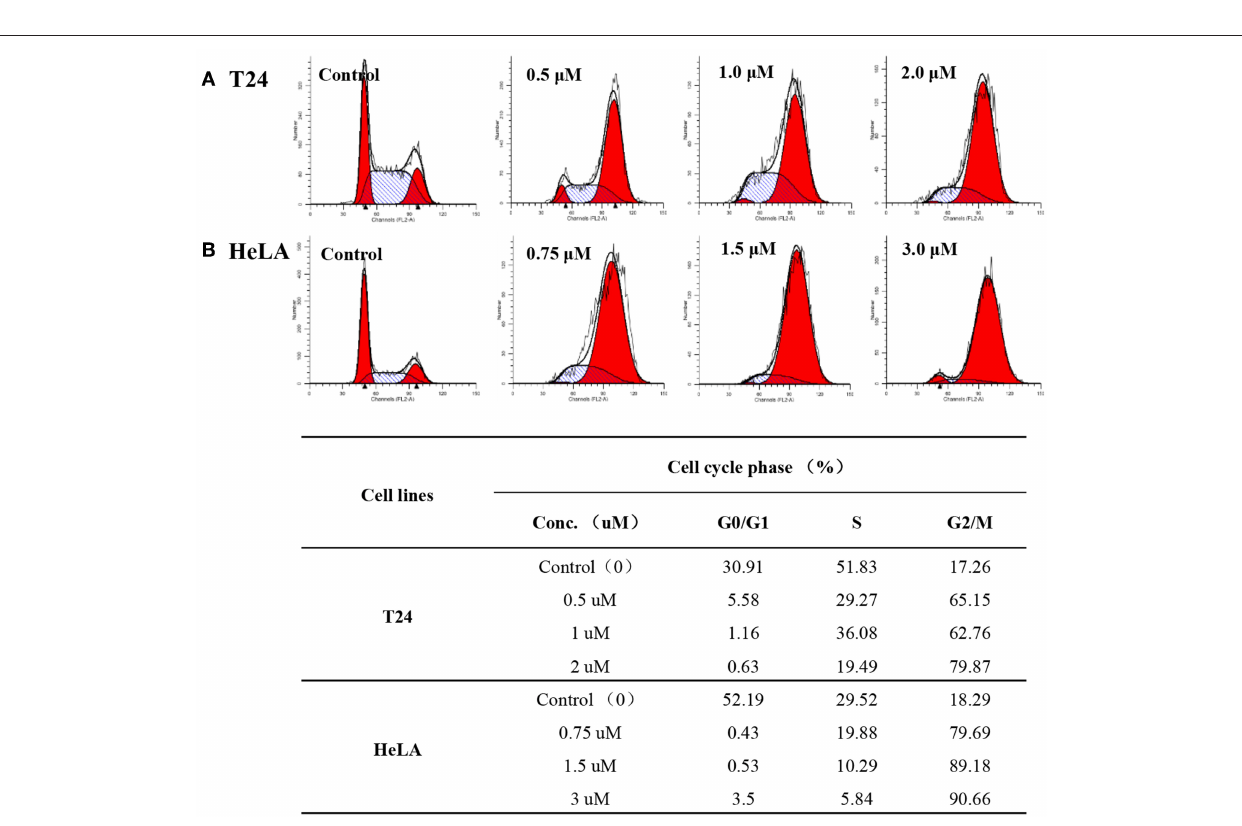
is composed of 7 α -helixes, 13 β -folds, and random